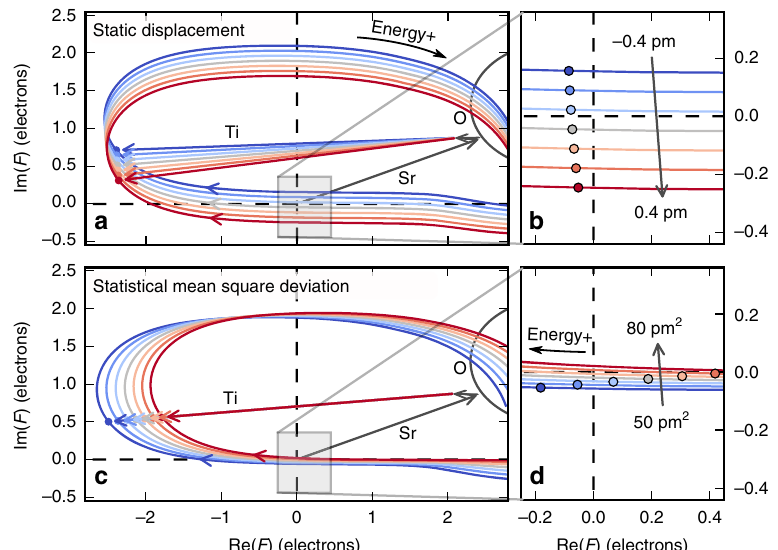
Fig. 1 Visualization of the methodological approach. Shown are curves described by the complex structure factor F as function of photon energy calculated via Eq. 3 for the speci fi c case of the 007 re fl ection of strontium titanate in vicinity of the Sr- K edge and neglecting fi ne structure for clarity. In a , c , vectors Sr , Ti , and O indicate the atomic contributions to the structure factor for the edge energy of 16,103 eV. The curves are a result of the sum of these vectors and the strong, resonant variation of the strontium contribution. The clockwise direction corresponds to increasing photon energy. Different colors (blue to red) correspond to a variation of mean static displacement ( a , b ) or statistical mean square deviation ( c , d ) of the titanium atom in the [001] direction. In the zoom on the origin ( b , d ), circles mark a selected energy of 16,000 eV corresponding to a structure factor close to the origin where the intensity is minimal. This shows that the energy position of the minimum depends very differently on the two structural